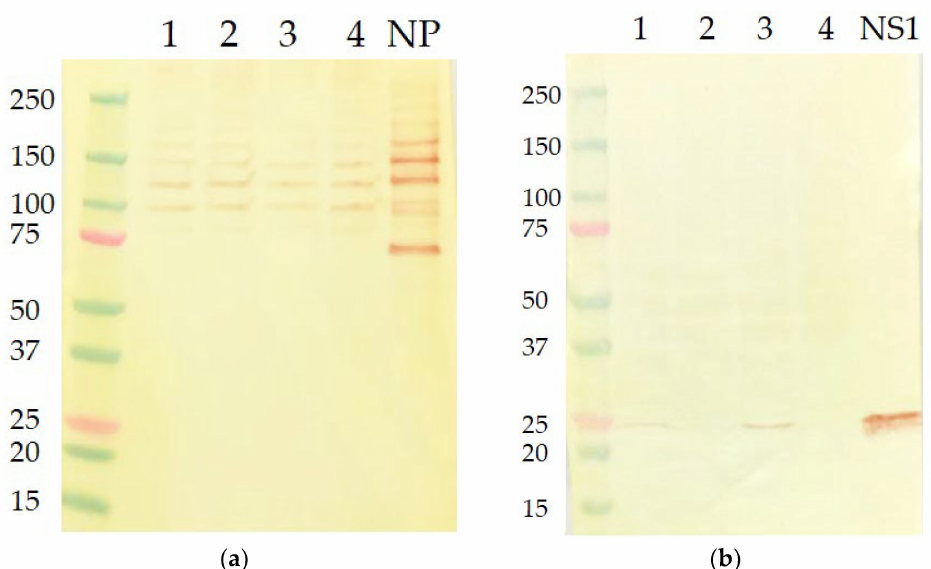
Figure 2. Analysis of NP expression in MDCK cells infected with recombinant LAIV viruses used in this study. ( a ) Western blot analysis using monoclonal anti-NP antibody after SDS-PAGE under non- reducing conditions; ( b ) Western blot analysis using monoclonal anti-NS1 antibody after SDS-PAGE under reducing conditions. 1—H7N9 6:2 NS1 full ; 2—H7N9 6:2 NS1 126 ; 3—H7N9 5:3 NS1 full ;